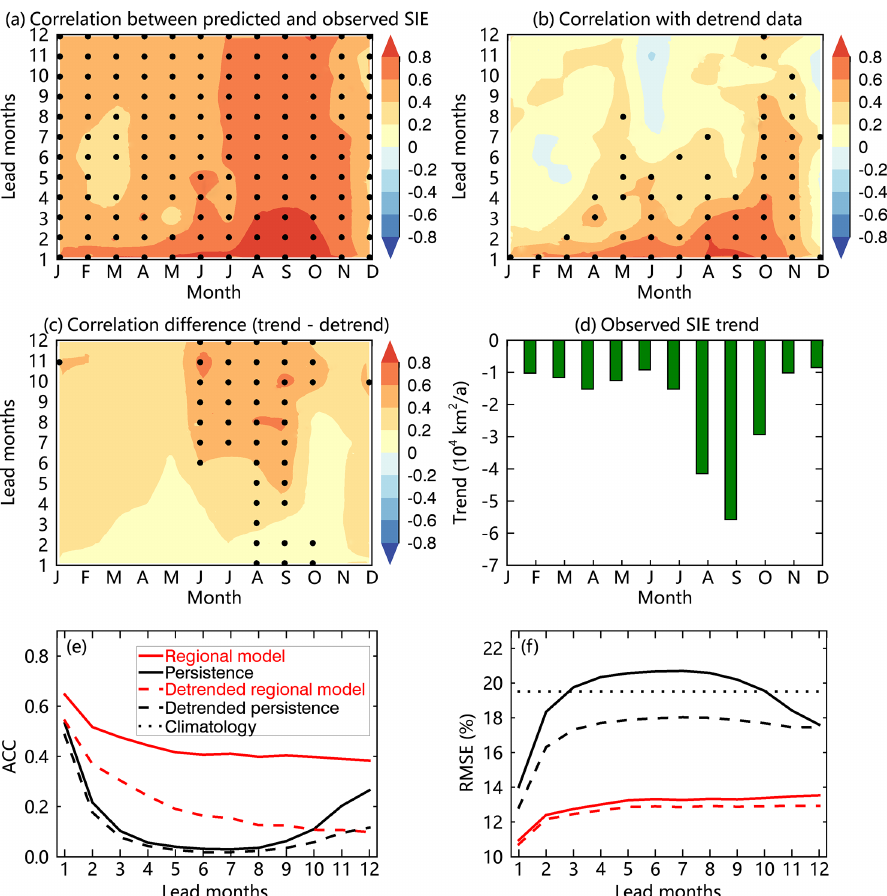
Figure 10. (a) The SIE forecast skill of the regional Markov model as a function of the calendar month and lead months. (b) The SIE forecast skill when monthly trends are removed from the predictions and observations, respectively. The black dots in (a) and (b) represent the correlations that are significantly above the 95% confidence level. (c) Difference between (a) and (b) . The black dots in (c) indicate that the correlation differences are significant above the 95% confidence level. (d) Observed trends in SIE as a function of the calendar month. All monthly SIE trends are significantly above the 95% confidence level. (e, f) The prediction skill of the regional Markov model compared against that of anomaly persistence and climatology averaged over the model domain as a function of the number of months of lead